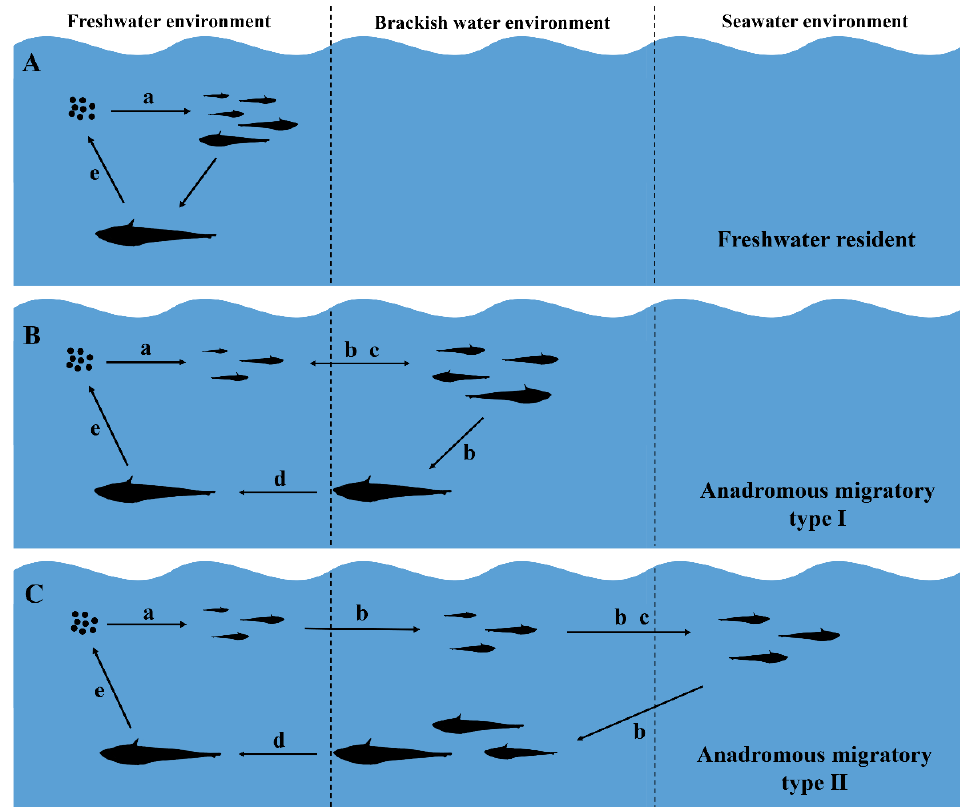
Figure 5. Life-history and habitat-use patterns observed for C. nasus from the Dayang River, China. ( A ) Freshwater resident, i.e., lived in freshwater throughout its entire life. ( B ) Anadromous migratory Type I, i.e., spawned in freshwater and moved at least once to a brackish environment (freshwater – brackish). ( C ) Anadromous migratory Type II, i.e., spawned in freshwater, moved to seawater, and then to brackish environment (freshwater – brackish – seawater). Notes: a : hatching; b : growth and feeding; c : overwintering; d : migrating; e : spawning.